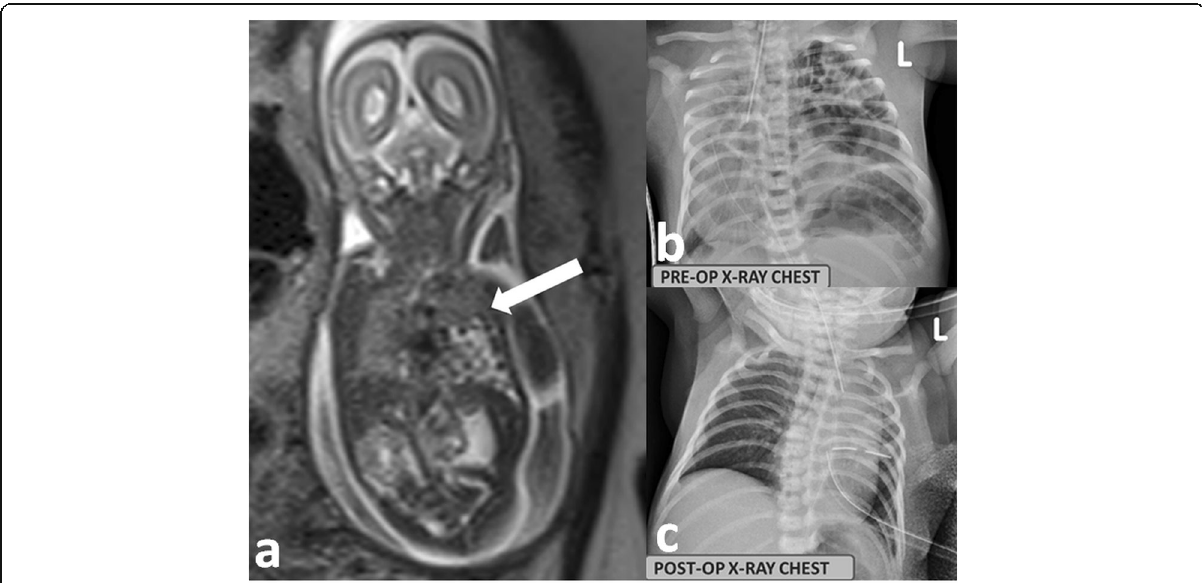
Fig. 4 Twenty-eight-year-old G2 P1 L1 at 21 weeks of gestation with features of left-sided diaphragmatic hernia. a Coronal T2-weighted MRI image of the fetal trunk showing the presence of stomach and small and large bowel loops in the thoracic cavity (arrow) with no discernible hypointense line between the left lung and abdominal viscera. b Postnatal chest radiograph taken on the 1st day of life showing multiple bowel loops in the left hemithorax with complete mediastinal shift to the right side. Endotracheal tube is noted in situ in the trachea which is deviated to the right side. The baby underwent diaphragm repair surgery. c Post-operative chest radiograph showing normal position of both domes of diaphragm with endotracheal tube and left intercostal drainage tube in situ